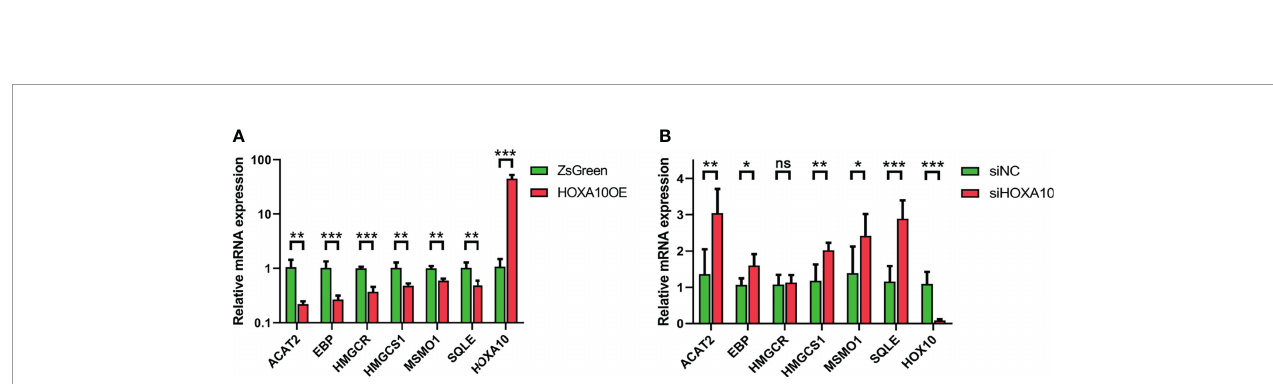
FIGURE 6 | Validation of mRNA expression of six key genes by qPCR. (A) The relative mRNA expressions of the six key genes in HOXA10OE and ZsGreen groups. (B) The relative mRNA expressions of the six key genes in siHOXA10 and siNC groups (HOXA10OE, HOXA10 over expression ESC; ZsGreen, control for HOXA10OE; siHOXA10, HOXA10 silence ESC; siNC, control for silence group; *p<0.05, **p<0.01, ***p<0.001. ns, no signi fi cant